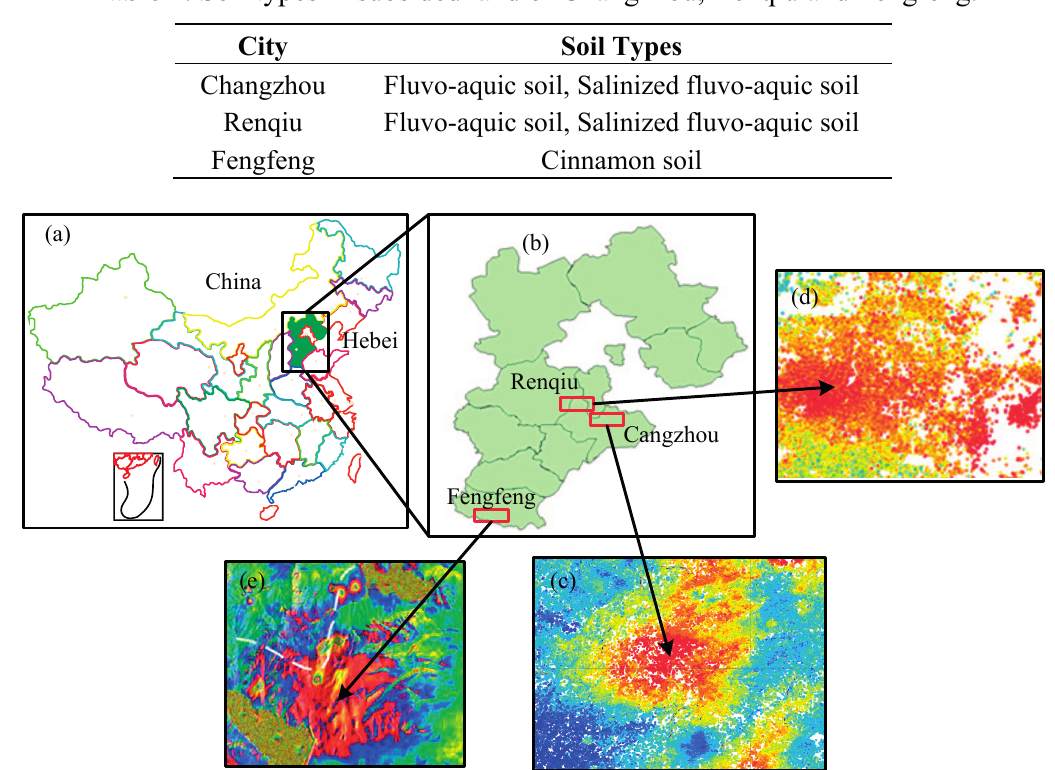
Table 2. Soil types in subsided land of Changzhou, Renqiu and Fengfeng.